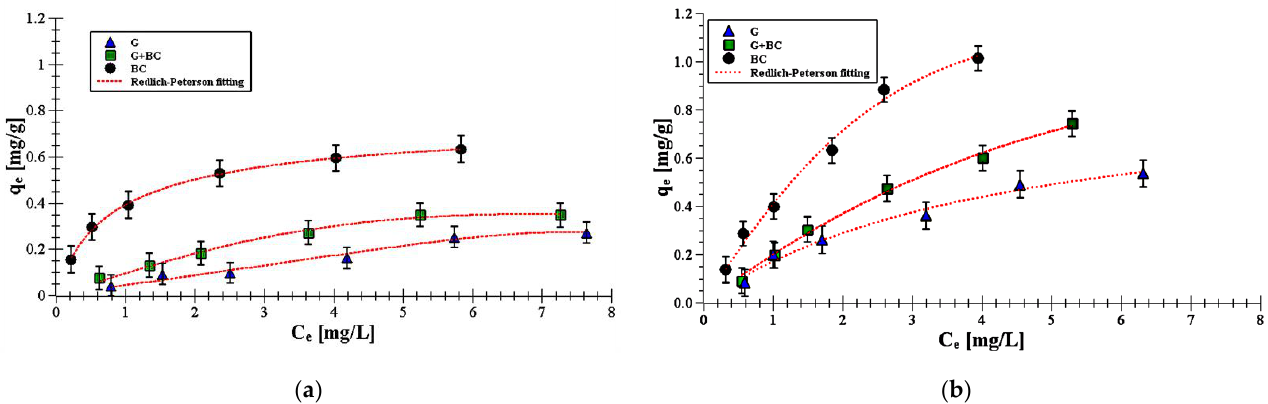
Figure 5. Adsorption equilibrium data of diuron ( a ) and carboxin ( b ) on the goethite, biochar and goethite–biochar mixture (points) as well as Redlich–Peterson fitting (lines) at pH 6.